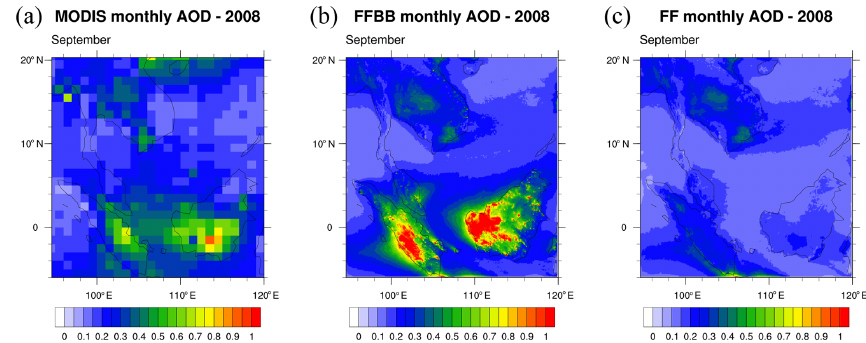
Figure 4. Monthly aerosol optical depth (AOD) in September 2008 from (a) Moderate Resolution Imaging Spectroradiometer (MODIS), (b) FFBB, and (c) FF.